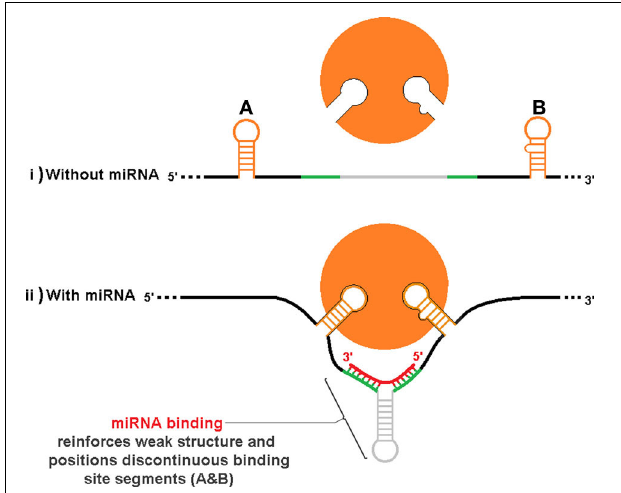
FIGURE 8 | Indirect influence of trans RNA modulation on complex RBP structural binding sites. As in Figure 7 , the same hypothetical mRNA is shown in both (i) and (ii), without and with an associate miRNA, respectively. Binding of the miRNA strengthens or orients a structure such that discontinuous RBP binding motif segments ( A,B ) are brought into proximity and/or orientation to facilitate binding to the protein. This is an abstract schematic, and is meant to represent a variety of possible scenarios where local structure may affect regional conformation such as to inhibit or promote function.